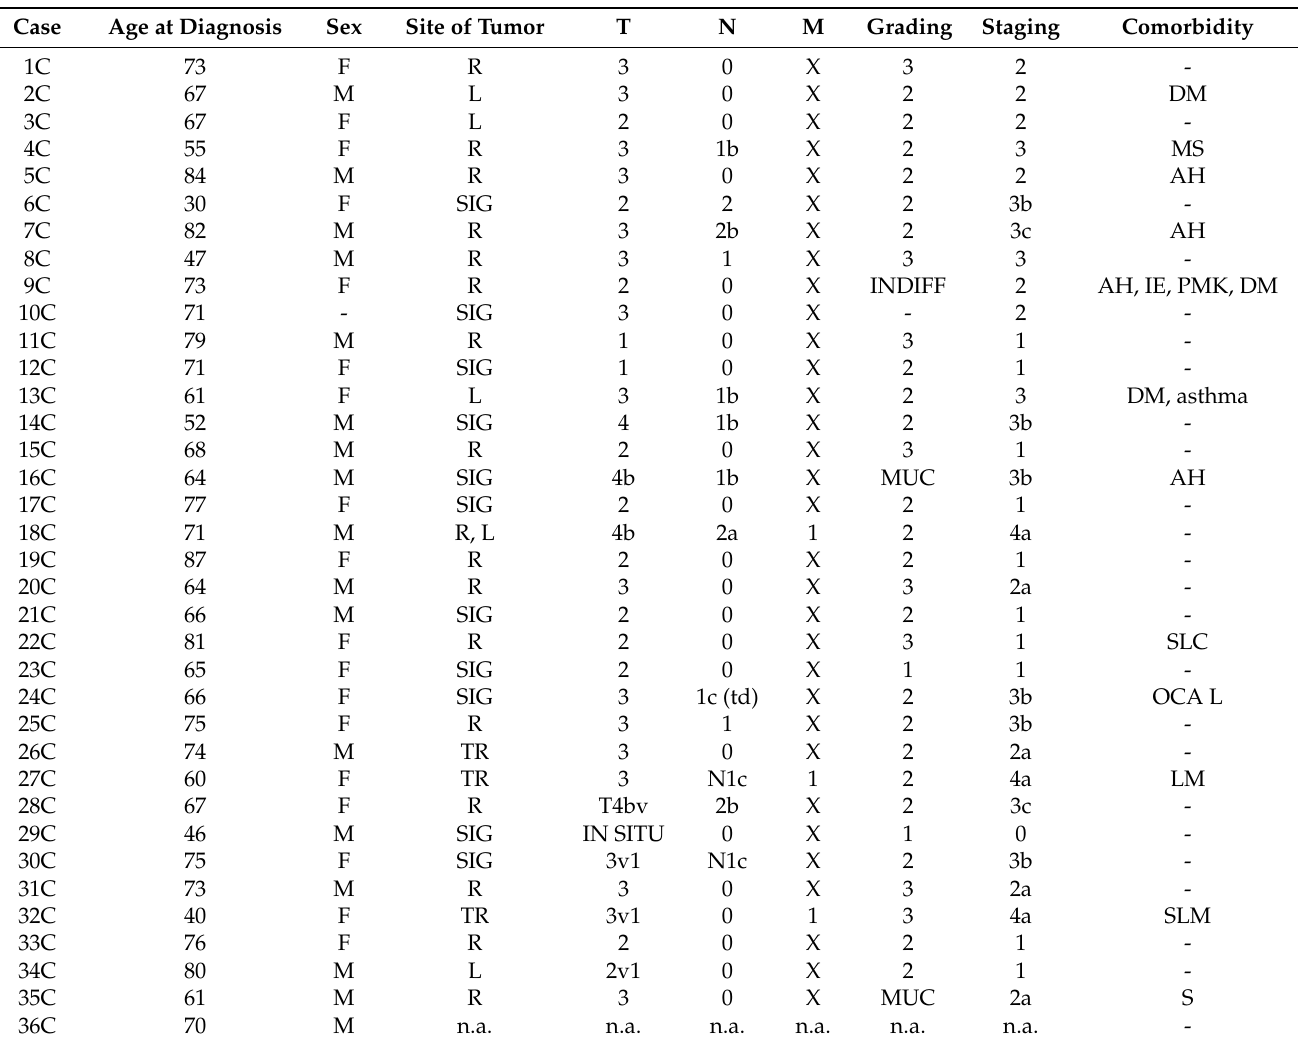
Table 1. Clinical and histopathological characteristics of patients with colon ADK.